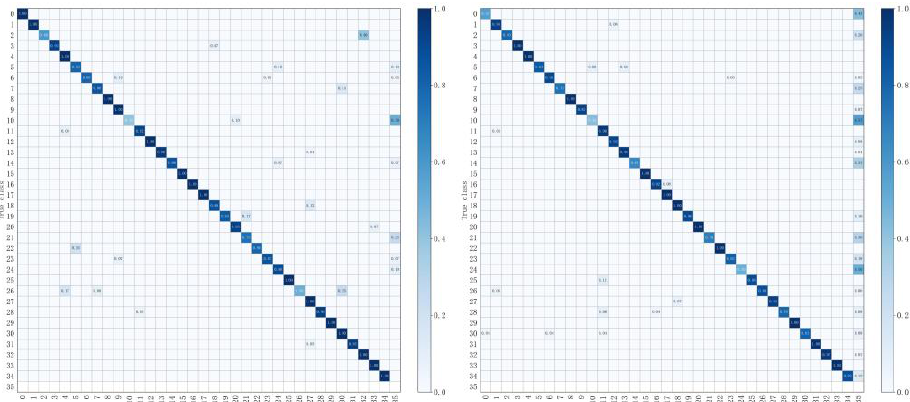
Figure 8. The confusion matrices of second and third step on RSI dataset.